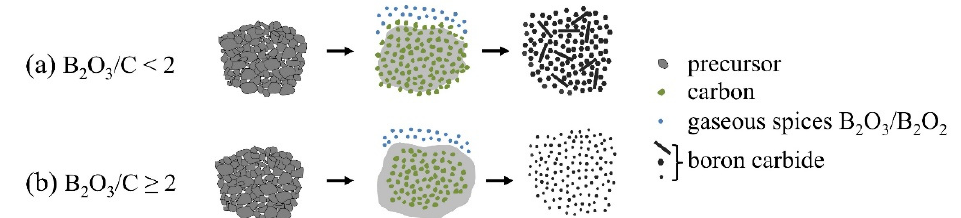
Figure 8. Schematic representation of formation mechanism of boron carbide particles for starting mixtures with different B 2 O 3 /C molar ratios, ( a ) B 2 O 3 /C < 2 and ( b ) B 2 O 3 /C ≥ 2.